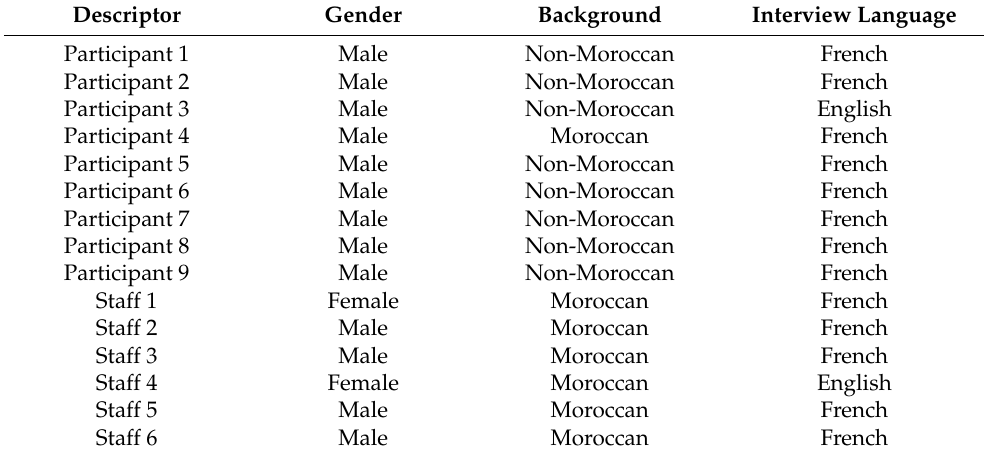
Table 3. Overview of